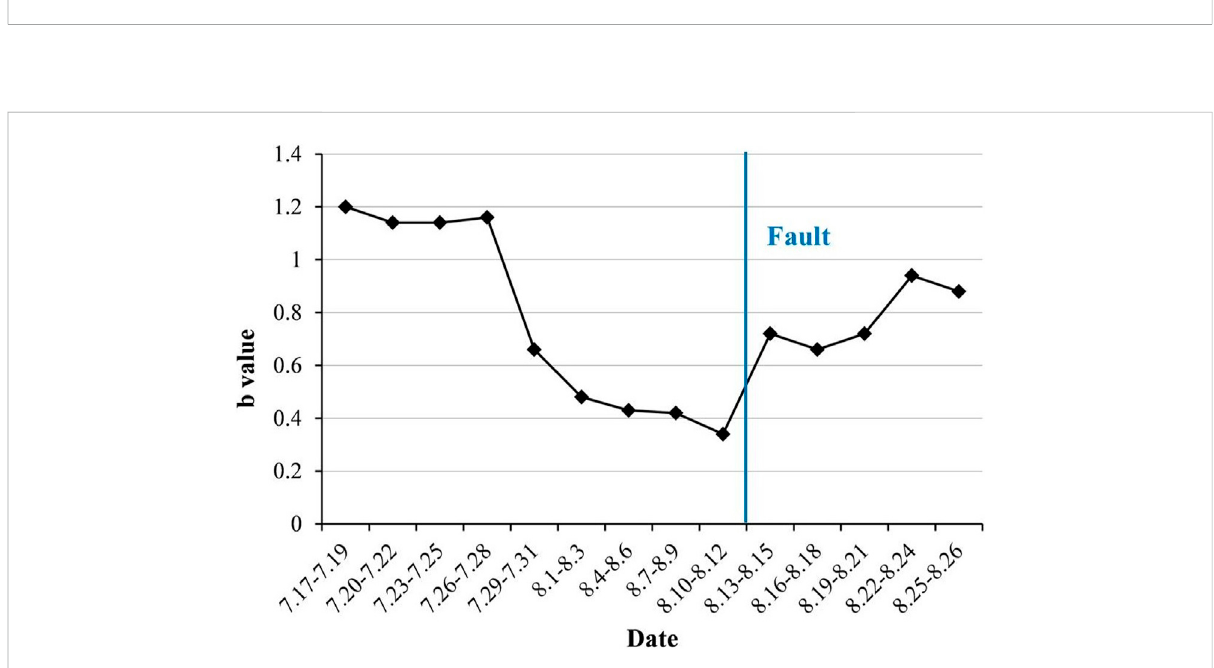
FIGURE 3 b Value of microseismic event when mining the panel through the